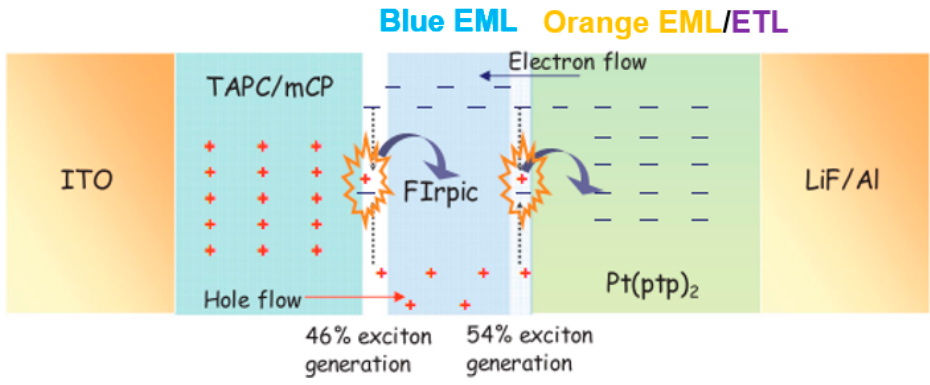
Figure 27. Proposed operational principles of the doping-free WOLED. Reproduced from Reference [226].